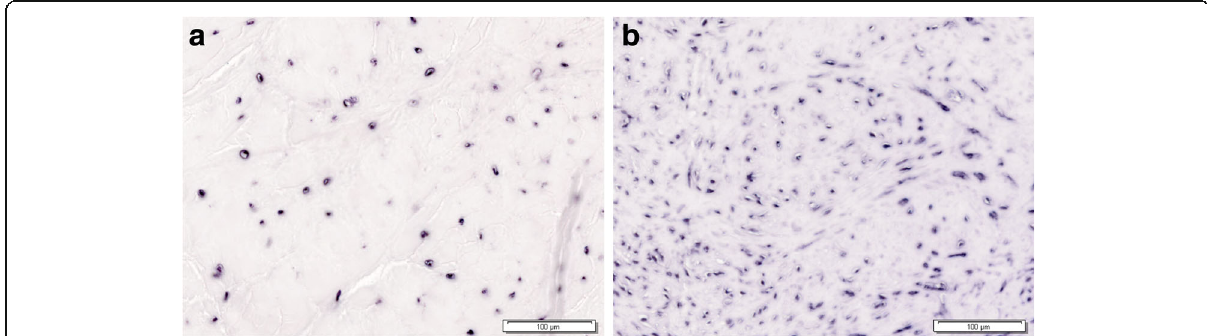
Fig. 5 In situ hybridization. Human medial menisci (red zone) stained with a specific riboprobe for human COMP. Cells are decreased in ( a ) the OA meniscus, compared with ( b ) the non OA